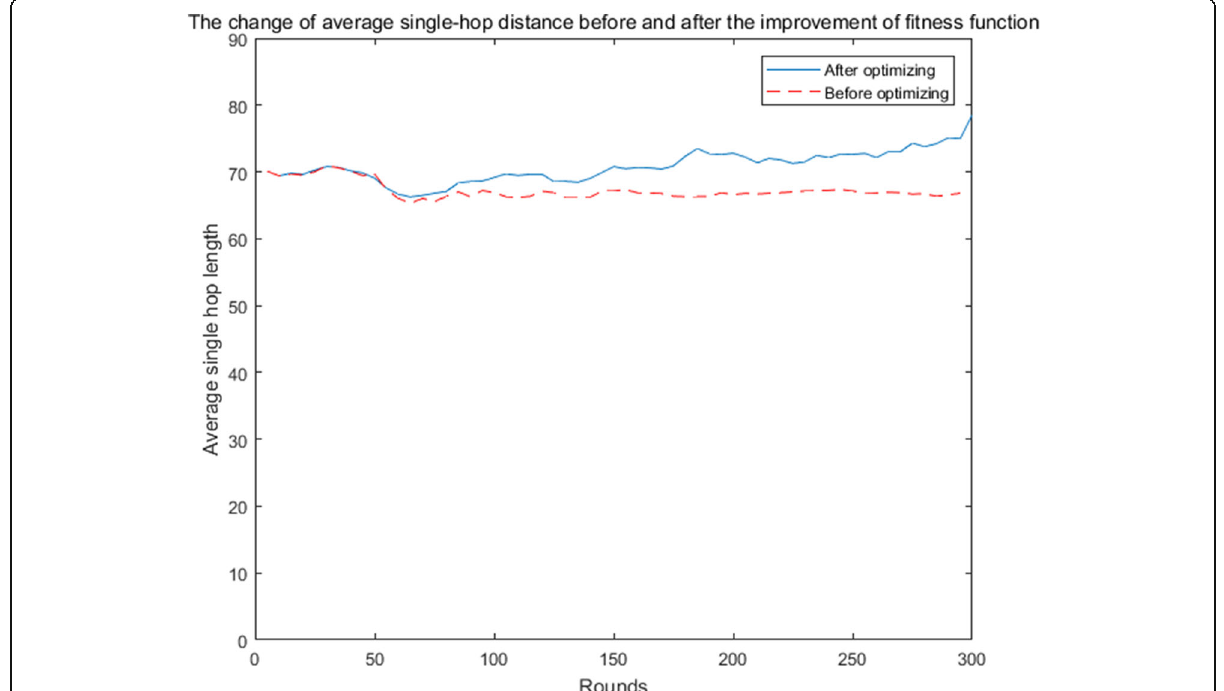
Fig. 15 The change of average hops before and after the improvement of fitness function. It shows that the improvement of fitness function affects the average single-hop distance of communication